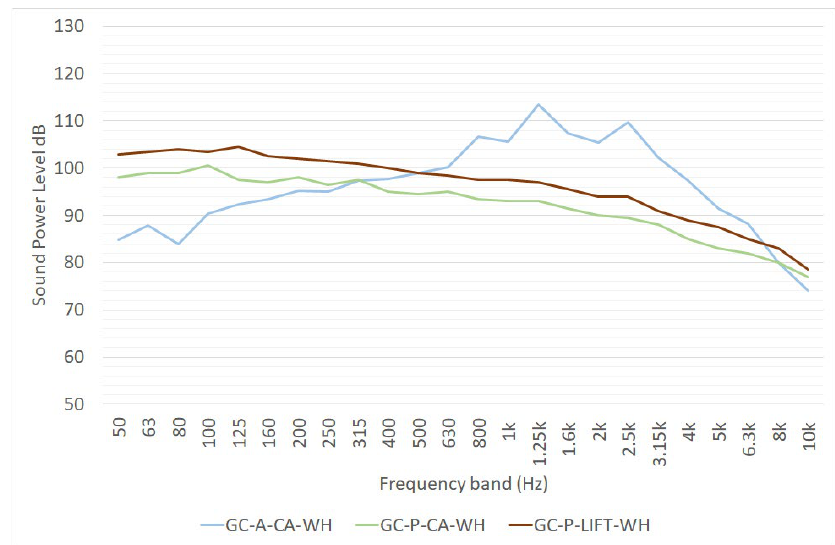
Figure 5. One-third octave sound power level spectra of gantry cranes, as reported in [16–18]. L W is expressed in dB for point sources, in dB/m for linear sources and in dB/m 2 for area sources. GA-P-CA-WH and GA-P-LIFT-WH data are taken from [17,18], GC-A-CA-WH from [16].